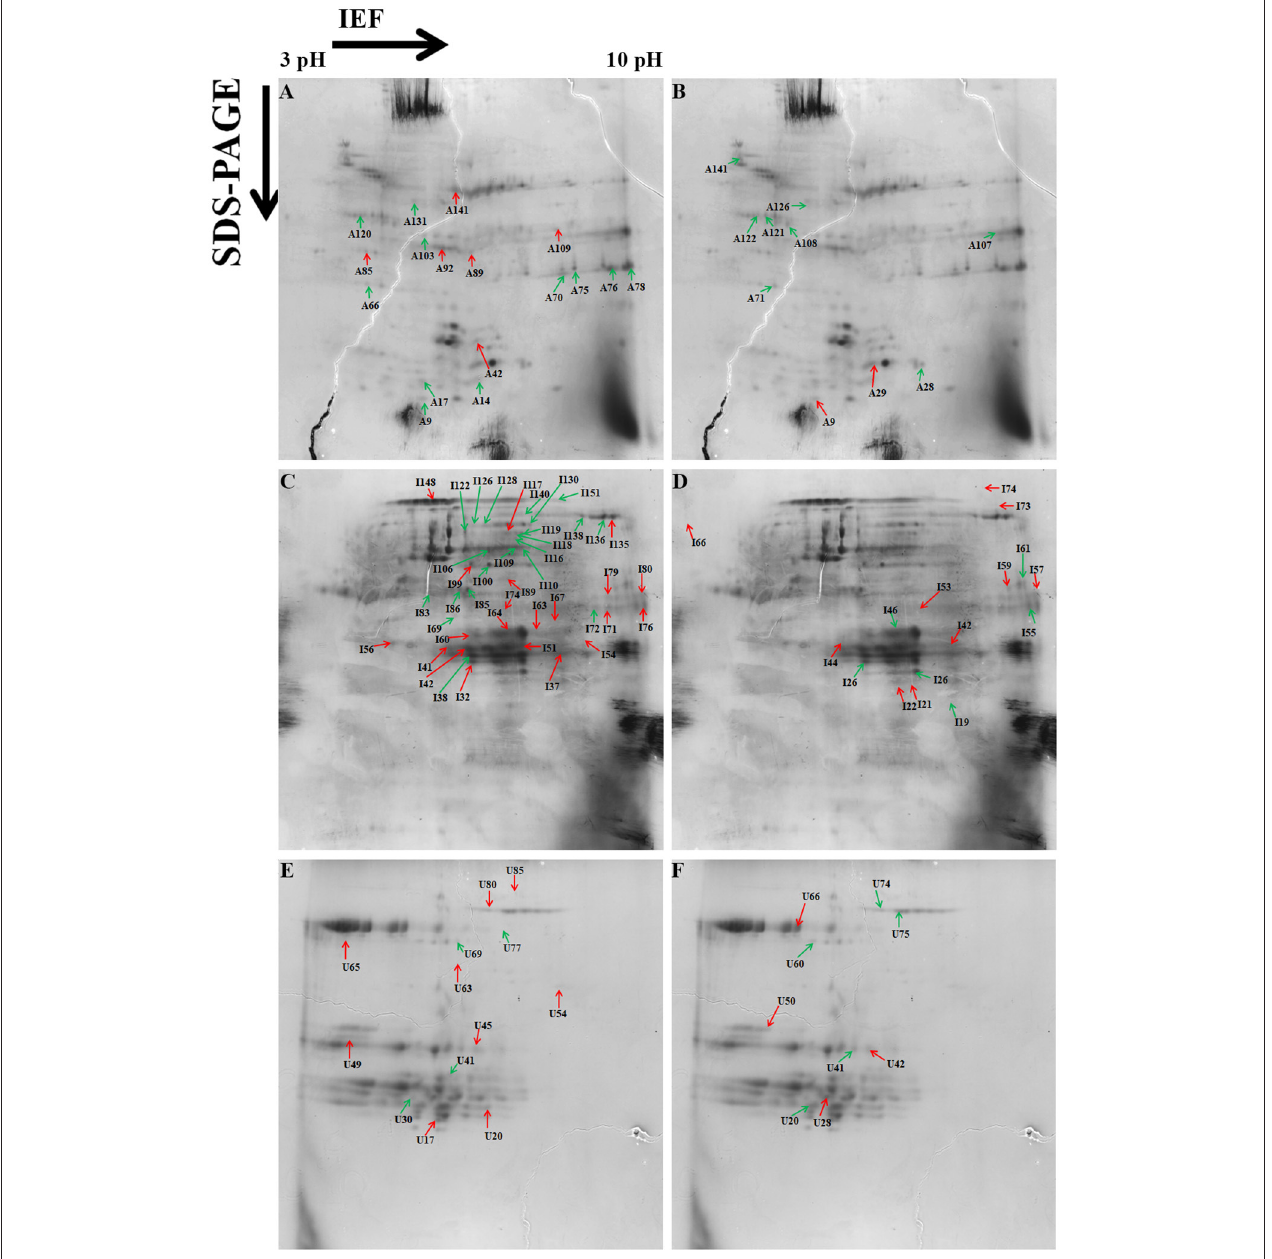
FIGURE 4 | Representative two-dimensional electrophoresis (2-DE) gels of the wheat grain proteins analyzed by Protein Pilot software from different protein fractions. (A) Albumins–globulins day stress, (B) gliadins day stress, (C) glutenins day stress, (D) albumins–globulins day–night stress, (E) gliadins day–night stress, and (F) glutenins day–night stress. Red-colored arrows indicate upregulated protein spots between control and treatment. Green-colored arrows indicate downregulated protein spots between control and treatment.